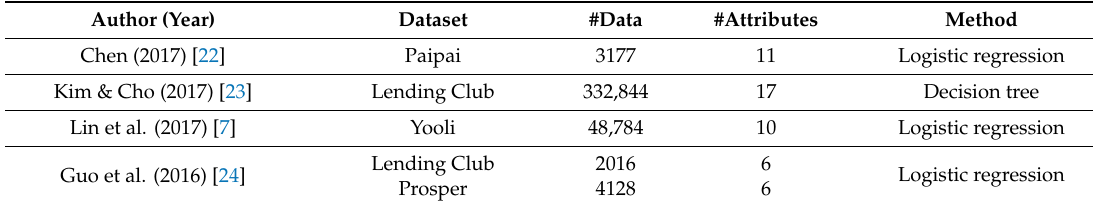
Table 3. Related works in P2P